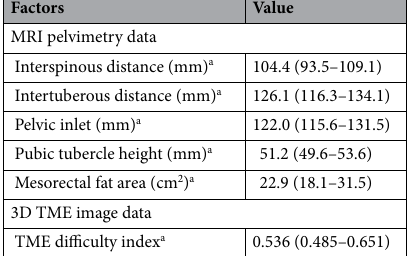
Table 2. Measurement results of MRI pelvimetry and for the TME difficulty index in all patients ( n = 65). MRI magnetic resonance imaging, TME total mesorectum excision. a Values are median (interquartile range).